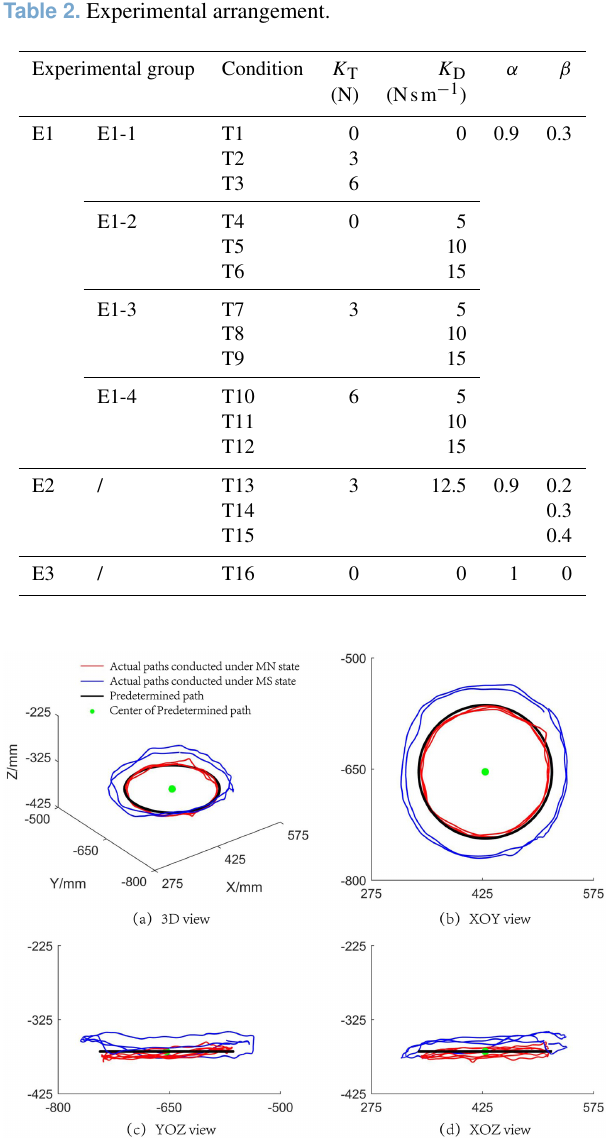
Figure 7. The actual paths traveled by the hand of subject S 1 under condition T14, showing (a) the 3D view of the paths as well as the (b) xoy , (c) yoz and (d) xoz views of the paths.